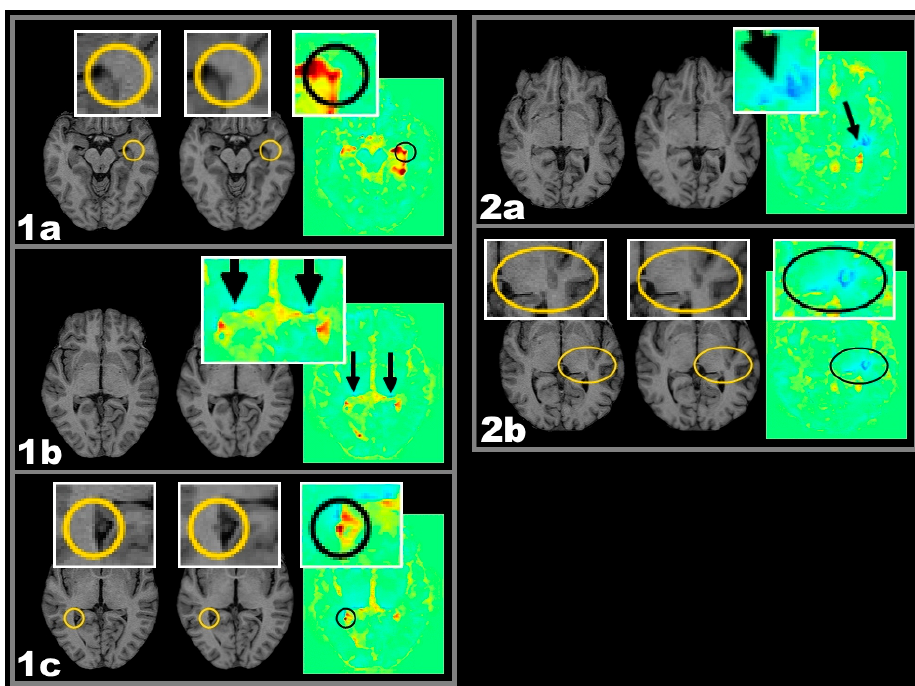
Figure 3. One year follow-up T1w MRI and respective colour coded VGM maps demonstrating different types of volume change. Important detail is highlighted in circles and elipses. Two exemplary cases with active lesions and spatially related lateral geniculate nucleus (LGN) volume decrease: Case 1 CEL, Case 2 CSL. From left to right: MRI-1, MRI-2, and VGM. Case 1 CEL: ( 1a – 1c ) Both LGN of this patient are showing a circumscribed blue VGM signal indicating >5% volume loss ( 1b ). Along the optic radiation, this is accompanied by CEL appearance within the left ( 1a ) and by NL appearance within the right ( 1c ) hemisphere; Case 2 CSL: ( 2a – 2c ) The left LGN area of this patient shows a decrease in size. Lateral to the LGN almost contacting the insular cortex, a CSL is visible with a streak of volume decrease between lesion and LGN ( 2a ) possibly representing atrophic fibres of the optic radiation. Important detail is highlighted in boxes and circles. LGN is highlighted by arrows.